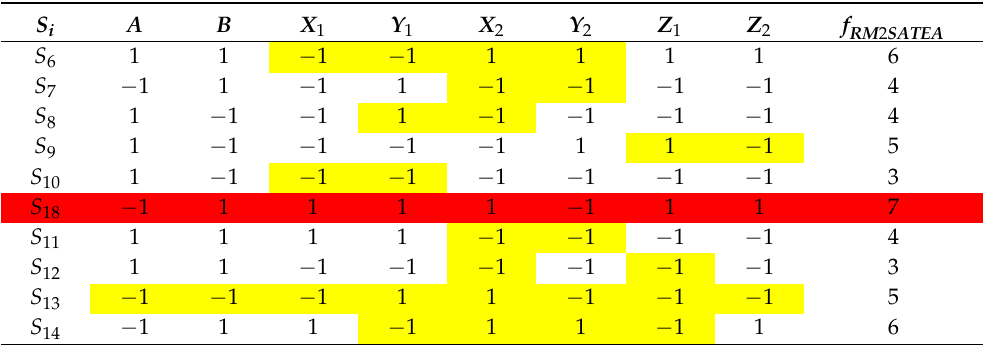
Note that Party 2 coalited with Party 3. The individual S 18 remained as candidate of this coalition party. (v) Election Day The final eligibility of all candidates from both coalition parties will be compared. If the eligibility value of the candidate is maximum ( f RM 2 SATEA = 7), the candidate will be elected. In this case, since S 18 achieved the maximum eligibility value and higher eligibility value than S 2 , S 18 selected as the